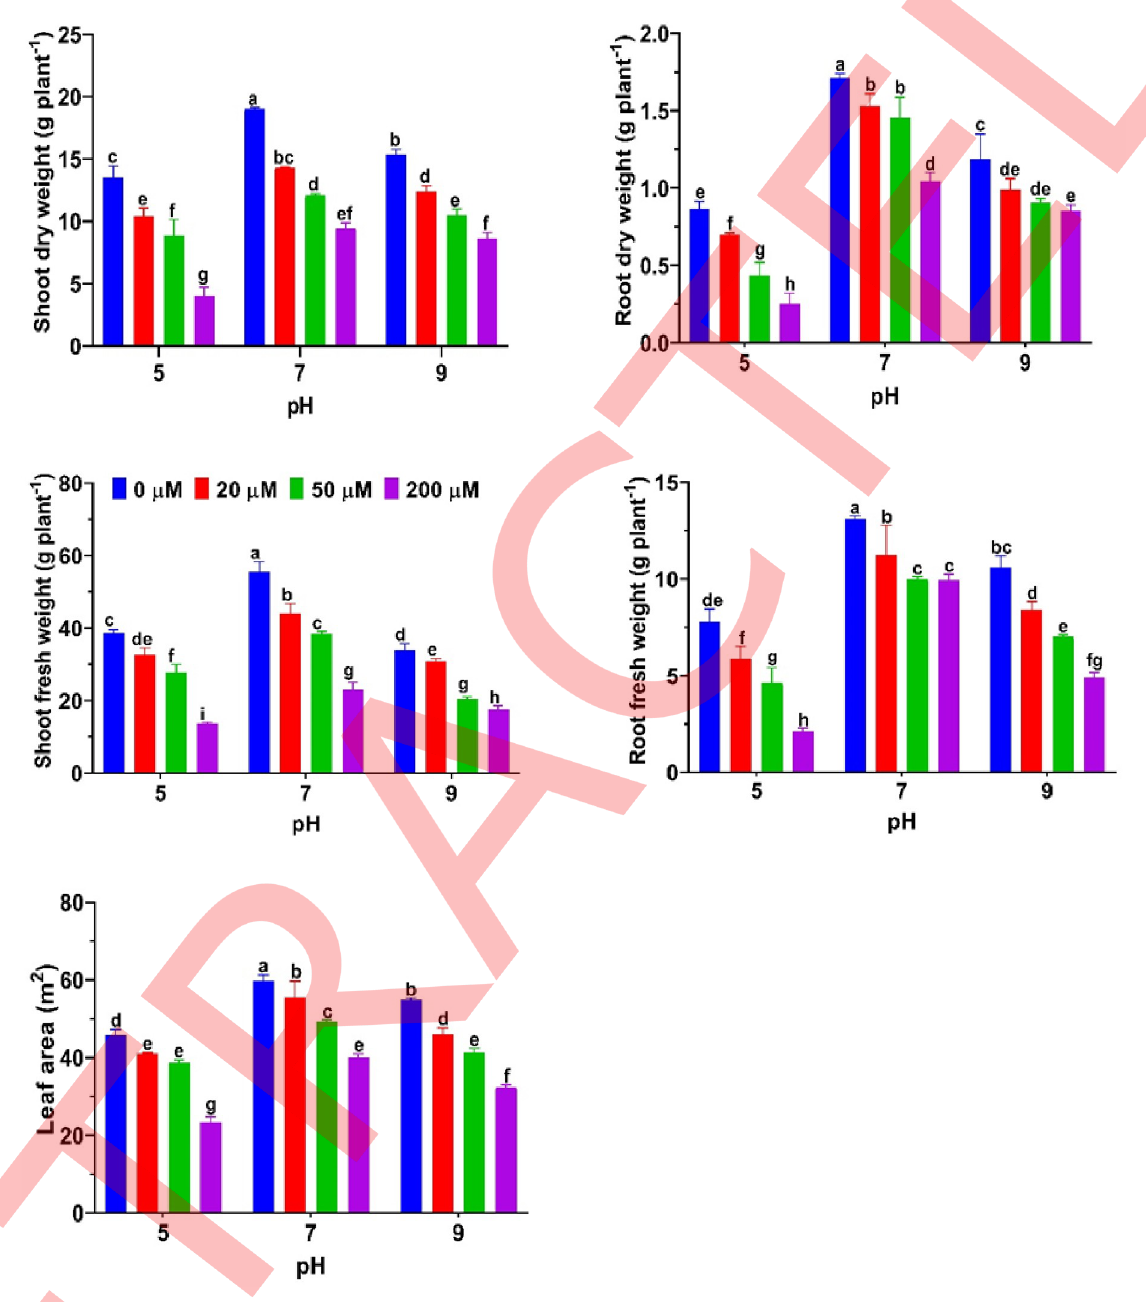
Fig 1. Effect of three different pH levels (5, 7, and 9) on growth parameters of cadmium (0, 20, 50, and 200)-stressed wheat plants.